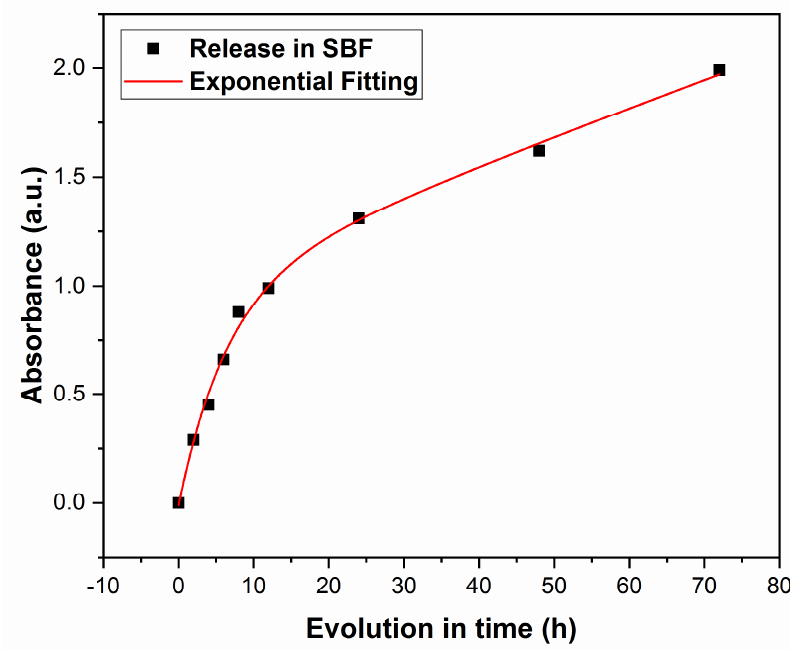
Figure 10. Time evolution of the solution’s absorbance.